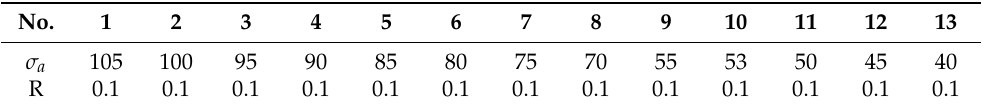
Table 3. Loading conditions of constant amplitude (CA) loading tests.